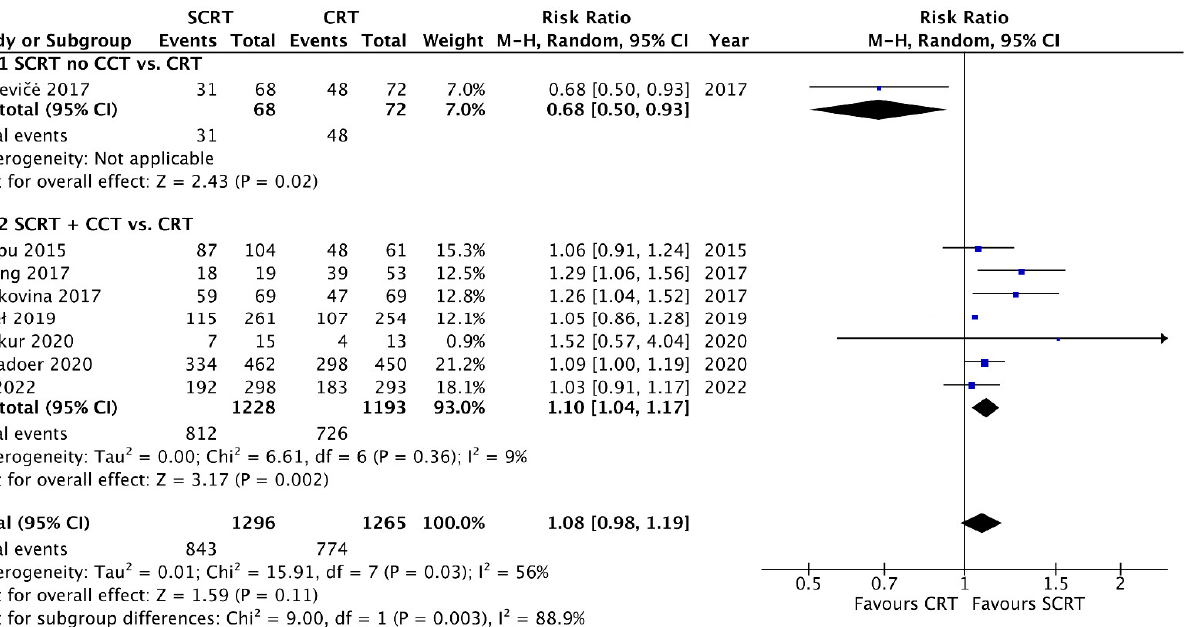
Figure 5. Forest plot of disease-free survival (DFS) events by Risk ratio (RR).